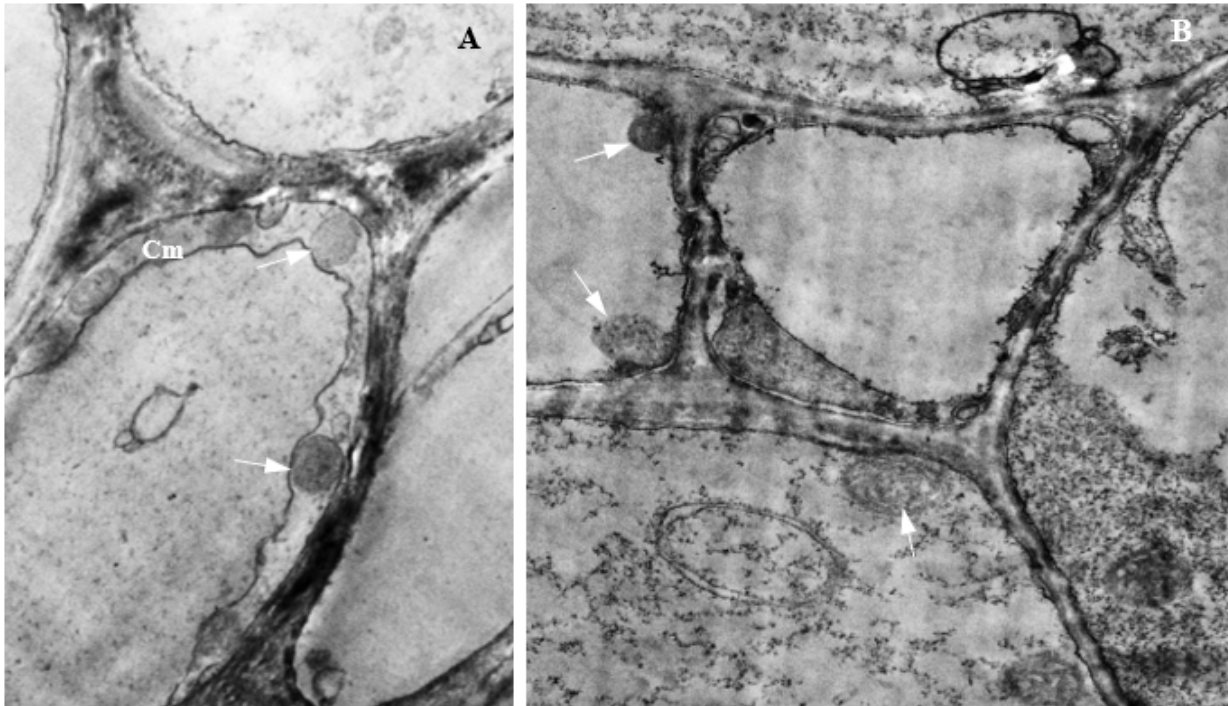
Figure 15. Transmission electron micrographs showing endophytic colonization of corn tissues by Fusarium sacchari . White arrows indicate the position of endophyte in ( A ) the presence of hyphae in cell membrane (Cm) of the infected root (Magnification 2500 × ); and ( B ) the attachment of hyphae to cell membranes of infected stem (Magnification 6300 ×